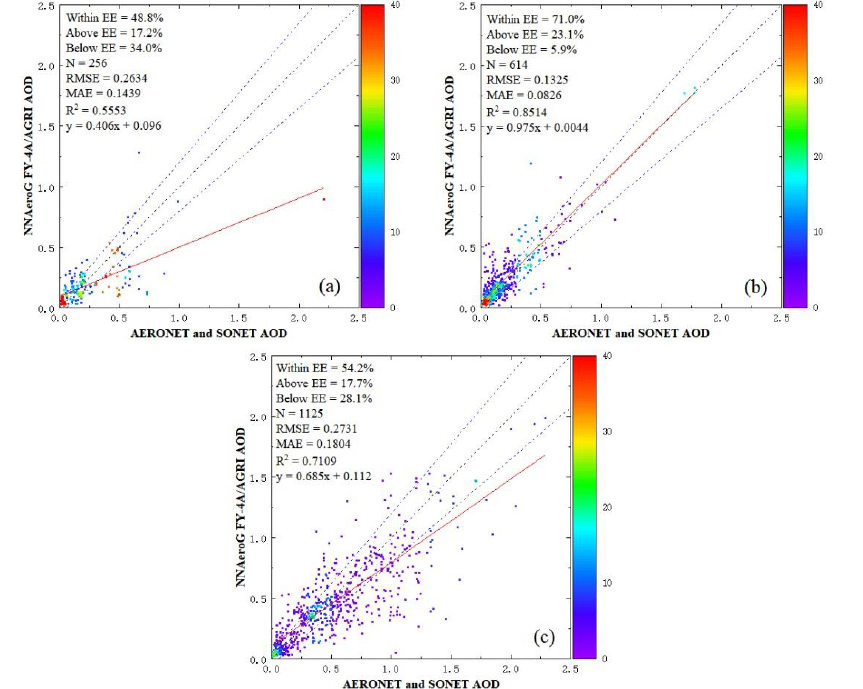
Figure 8. Scatterplots of the fine and coarse mode AOD retrieved using FY-4A/AGRI data versus AERONET and SONET reference data. ( a ) FMF ≤ 0.4, ( b ) 0.4 < FMF < 0.7, ( c ) FMF ≥ 0.7. The blue lines are the EE envelopes for AOD of ± (0.05 + 15%). The red line is the linear fitting line of AOD. The black line represents the 1:1 line.